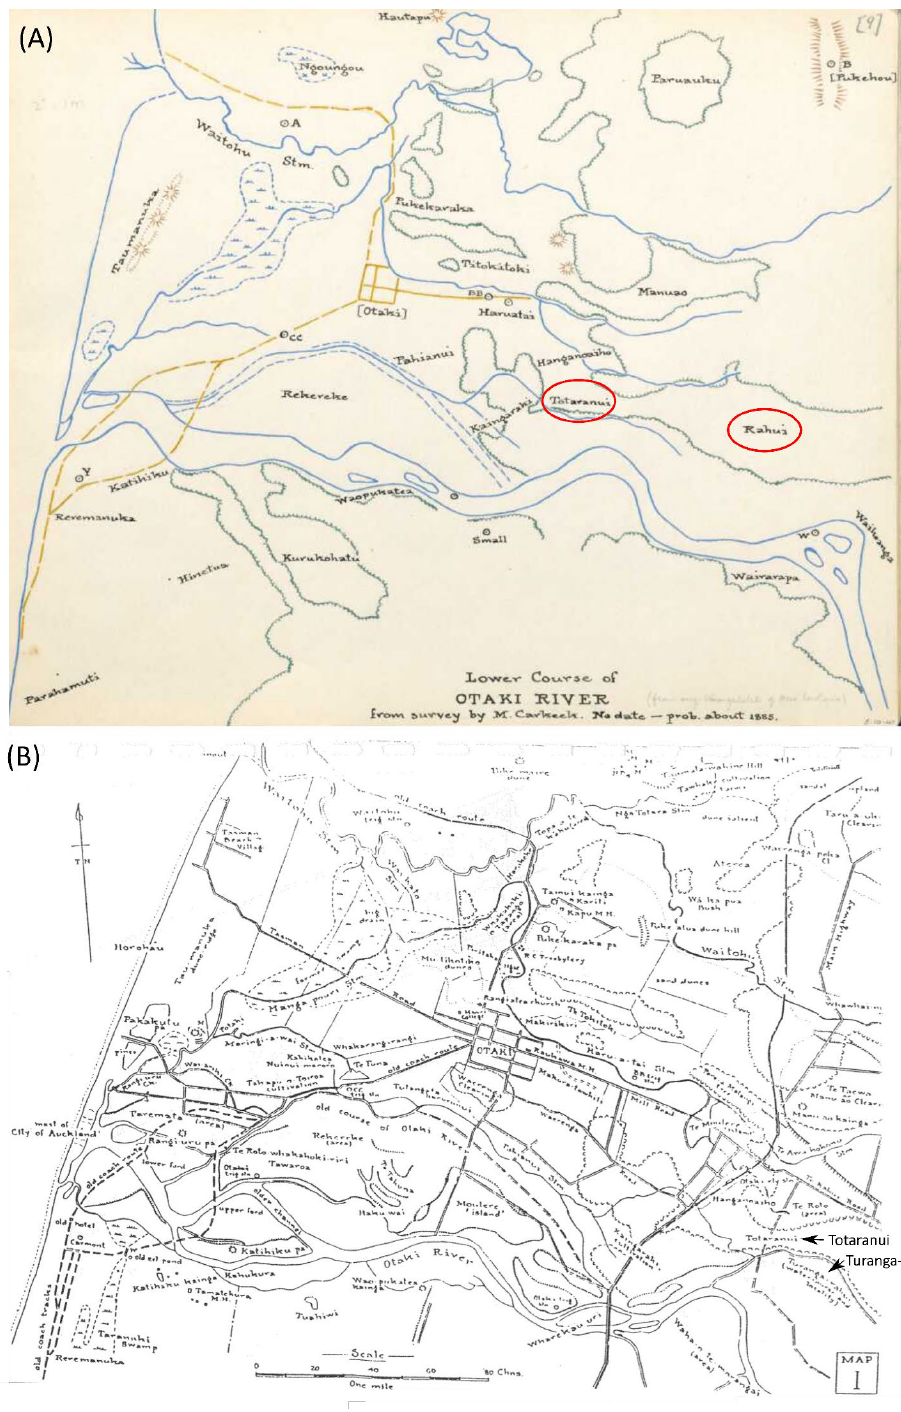
Figure 6. ( A ) Earliest available map of lower ¯Otaki River, ca. 1885, high-resolution image available online [60]; ( B ) ¯Otaki River, ca. 1930 [5]. Prior to European occupation in the later 1800s, much of the coastal plain was covered in forest, other than river corridors and wetlands. The area clear of forest labelled Rahui and circled in ( A ) was a subsidiary branch of a large anabranch of the ¯ Otaki named Turanga-rahui ( B , arrow). Totaranui (circled, ( A ); arrow, ( B ), is described as a rich alluvial floodplain intersected by deep and normally sluggish watercourses [61]. Former channels are clearly visible in a LiDAR-derived DEM (Figure